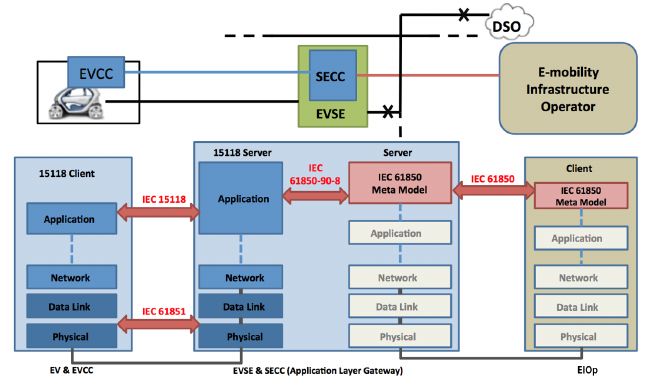
Figure 1. Architecture and standards for the Electric Vehicle (EV)